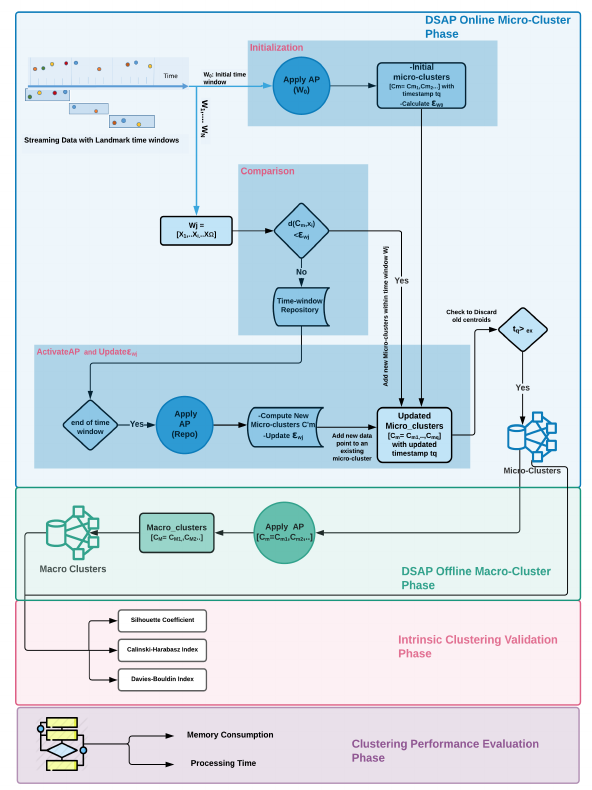
Figure 1: Flowchart of the proposed DSAP